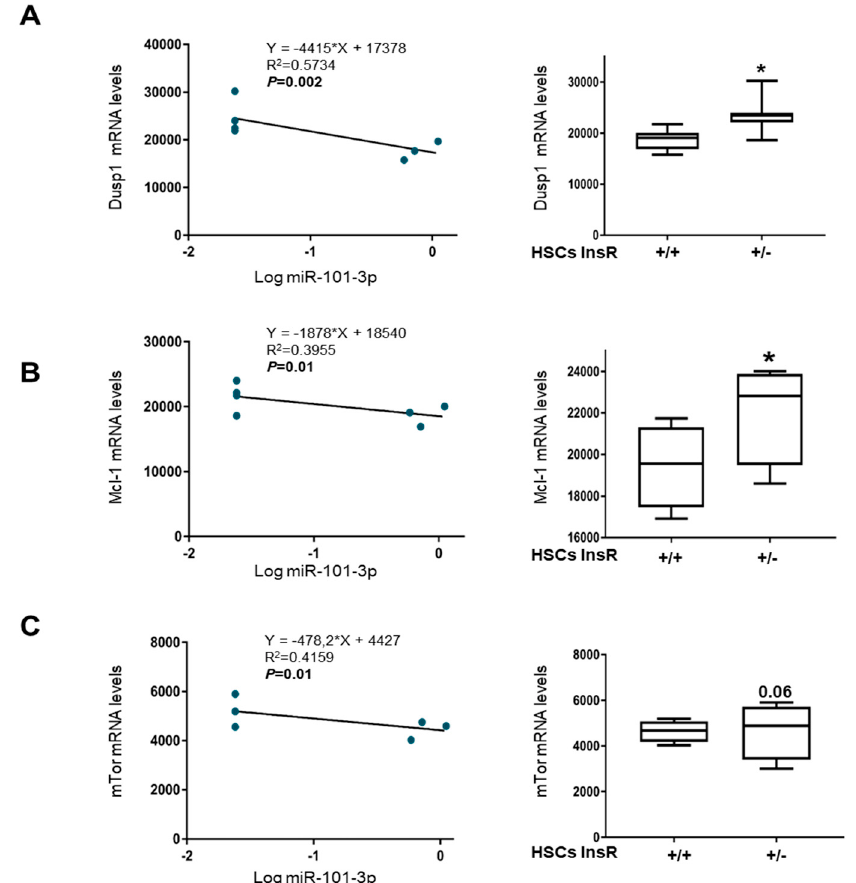
Figure 5. Predicted gene targets of miR101b-3p were up-regulated in InsR+/ − HSCs. Correlation analyses between miR-101-3p analyzed in wt and InsR+/ − HSCs and dual specificity protein phosphatase 1 (Dusp1). Dusp1 mRNA levels in wt and InsR+/ − HSCs by RNAseq ( A ). Correlation analyses between miR-101-3p assessed in wt and InsR+/ − HSCs and Mcl-1. Mcl-1 mRNA levels in wt and InsR+/ − HSCs by RNAseq ( B ). Correlation analyses between miR-101-3p analyzed in wt and InsR+/ − HSCs and mammalian target of rapamycin (mTor). mTor mRNA levels in wt and InsR+/ − HSCs by RNAseq ( C ) ( n = 4/group; * p < 0.05 vs. wt (InsR+/+) HSCs).